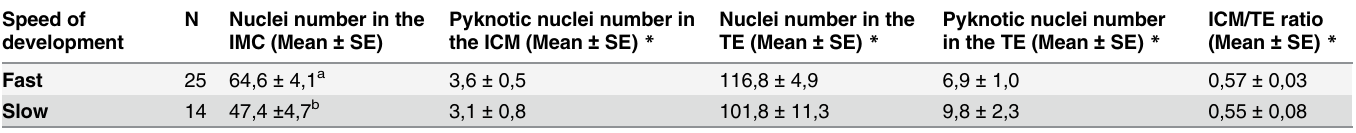
Table 4. Nuclei number in the ICM and TE from hatched blastocysts 9 days after IVF (Be — D9), supplemented with BSA, classi fi ed according to the speed of development (Fast or Slow). Speed of development